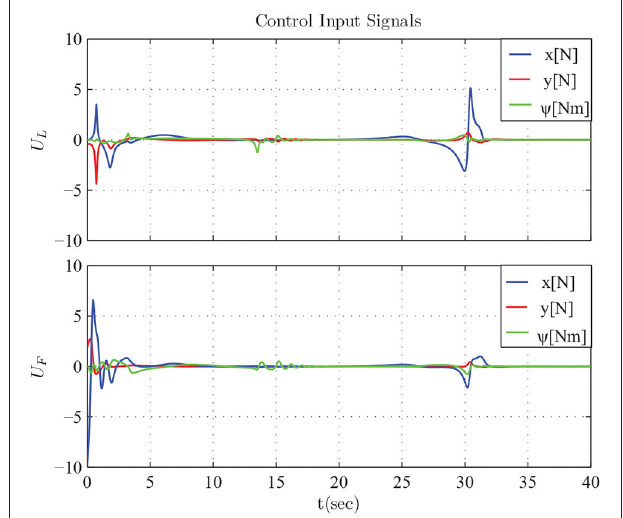
FIGURE 14 | The control input signals U L and U F .